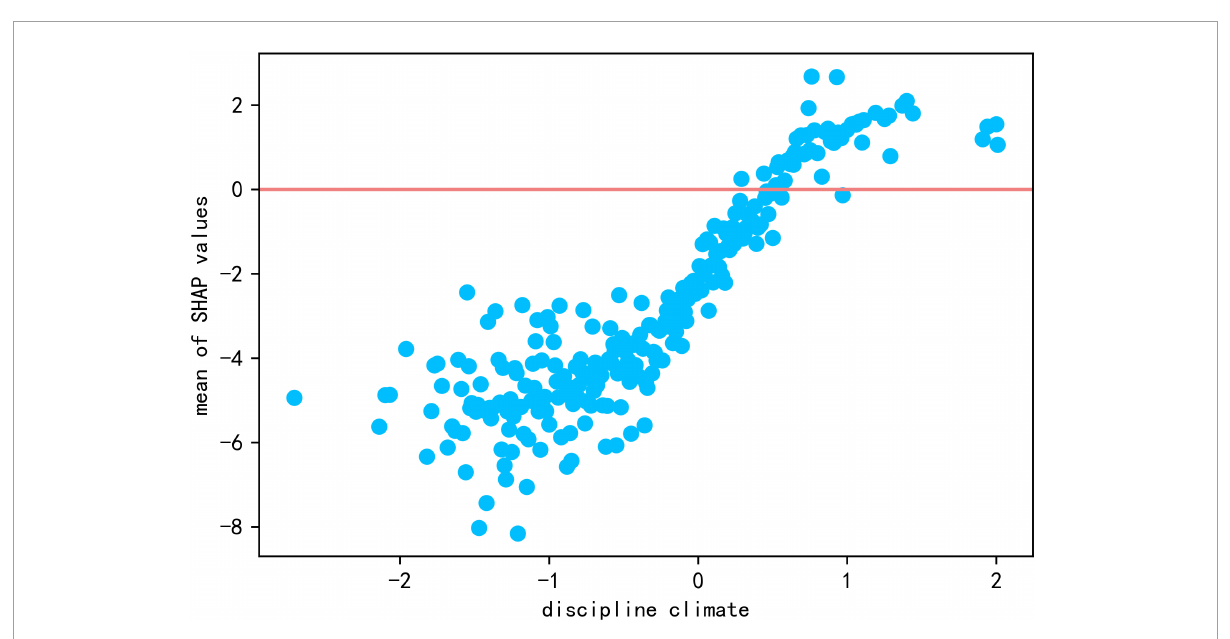
FIGURE8 The scatter plot of discipline climate and Shap